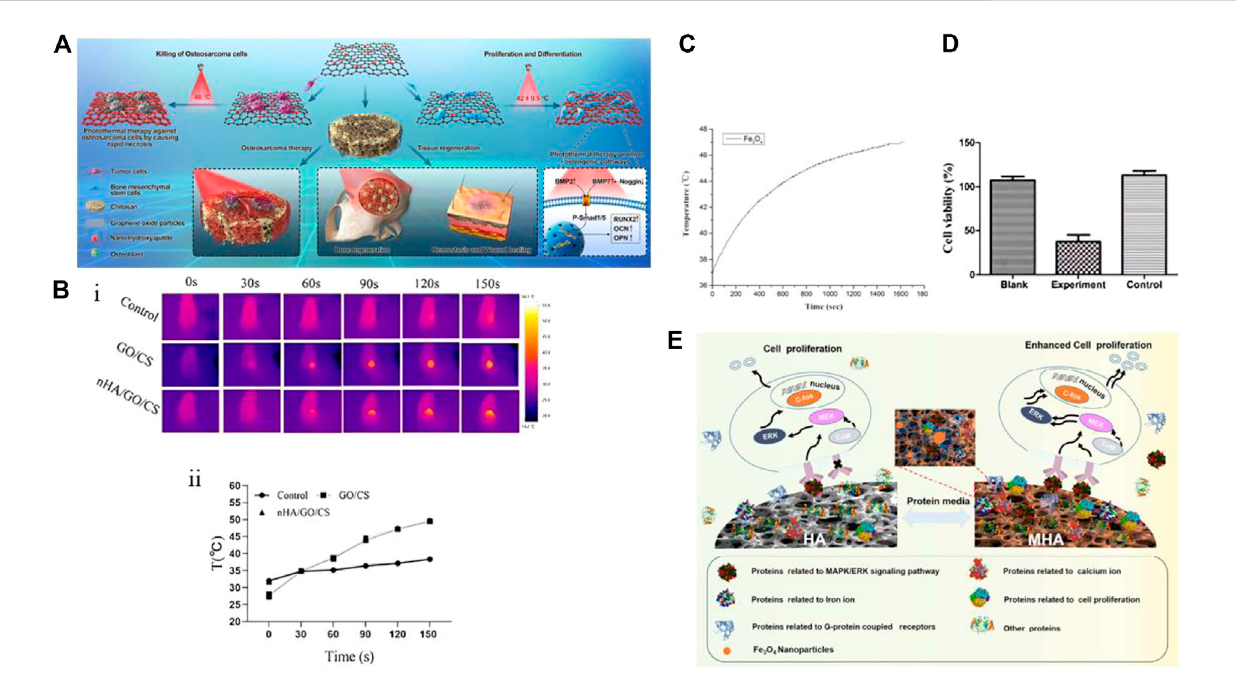
FIGURE 4 (A) Schematic diagram of the preparation and biological application of nHAp/GO particles and nHAp/GO/CS scaffolds. (B) Photothermal performance of nHAp/GO/CS scaffold on osteosarcoma after irradiation with near-infrared (NIR) at 808 nm (0.6 W/cm 2 ) for 150 s. In vivo infrared thermal image (Bi) and temperature rise curve (Bii) of HOS tumor tissue. (C) Magnetic heating performance of PLGA/MF-nHAP under a frequency of 500 kHz and a magnetic fi eld intensity of 3 mT. The material temperature increased with increasing reaction time. (D) Cell survival rate of MG-63 cellsco-culturedwithnanoparticlesandexposedtoamagnetic fi eldfor30 min,measuredbyCCK-8assay.TheexperimentalgrouphadPLGA/MF-nHAP and an external magnetic fi eld applied, the Black group had no nanoparticles, and the Control group had PLGA/MF-nHAP but no external magnetic fi eld applied. About 78% of MG-63 cells in the experimental group were non-viable after magnetic heating treatment. (E) Mechanism of MHAp scaffold material in promoting the proliferation of MC3T3-E1 cells. (A) , (Bi) and (Bii) Reproduced with permission (Ma et al., 2020). Copyright 2020,